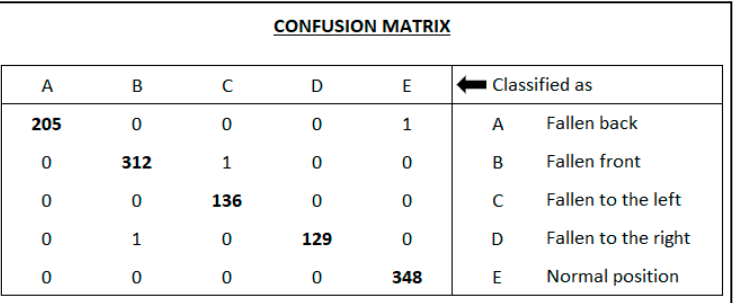
Figure 11. Confusion matrix.